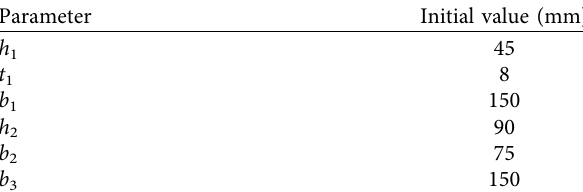
Table 2: Initial values of